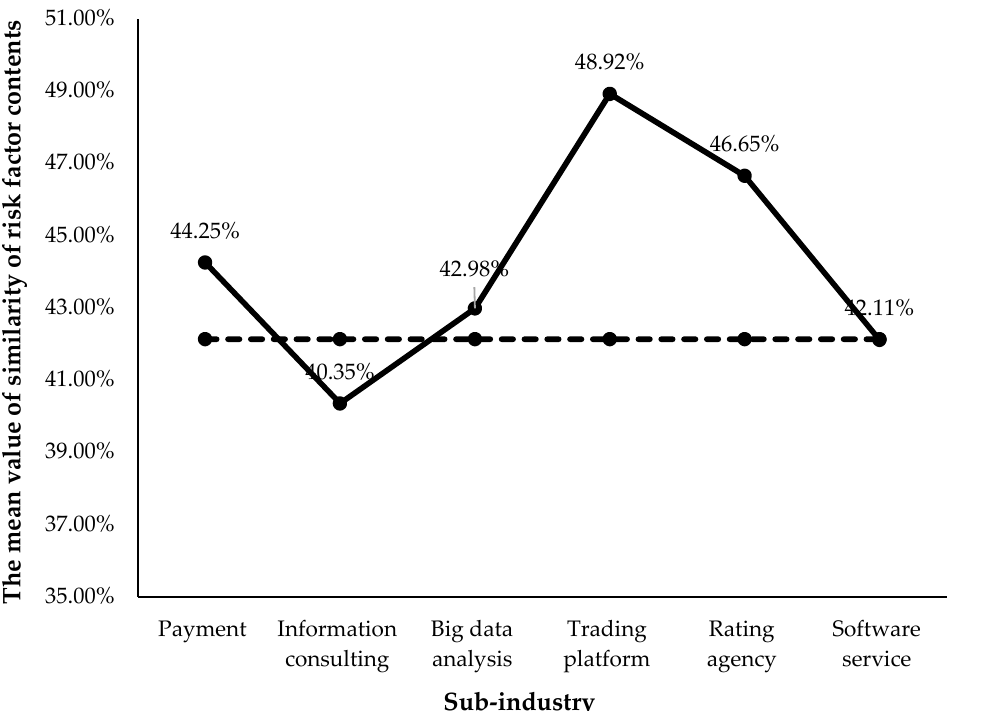
Figure 6. The mean value of similarity of risk factor contents among different fintech subsectors over the period 2015 to 2019.